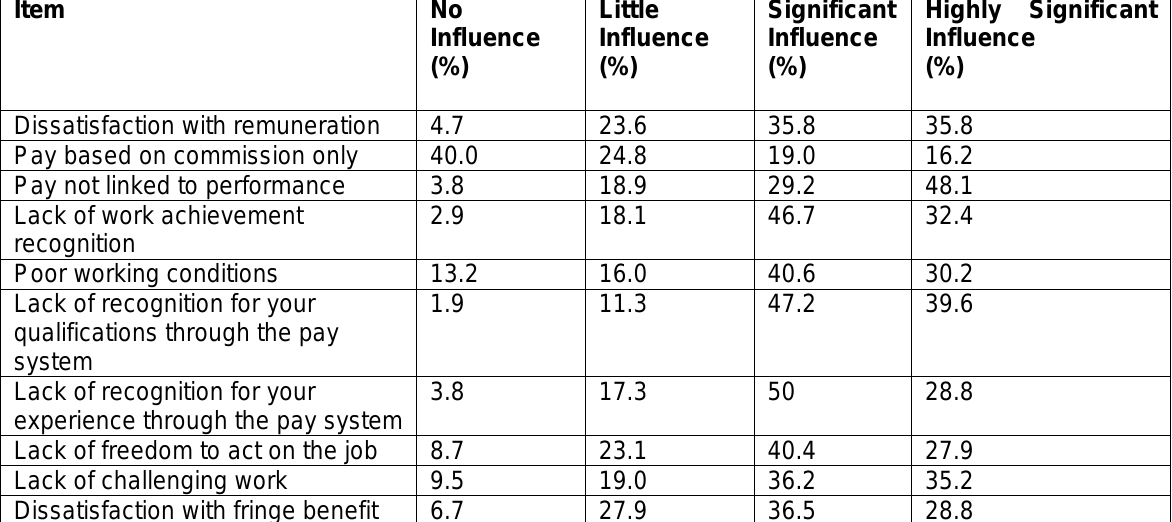
Table 3: Perceived influence of intrinsic and extrinsic rewards on